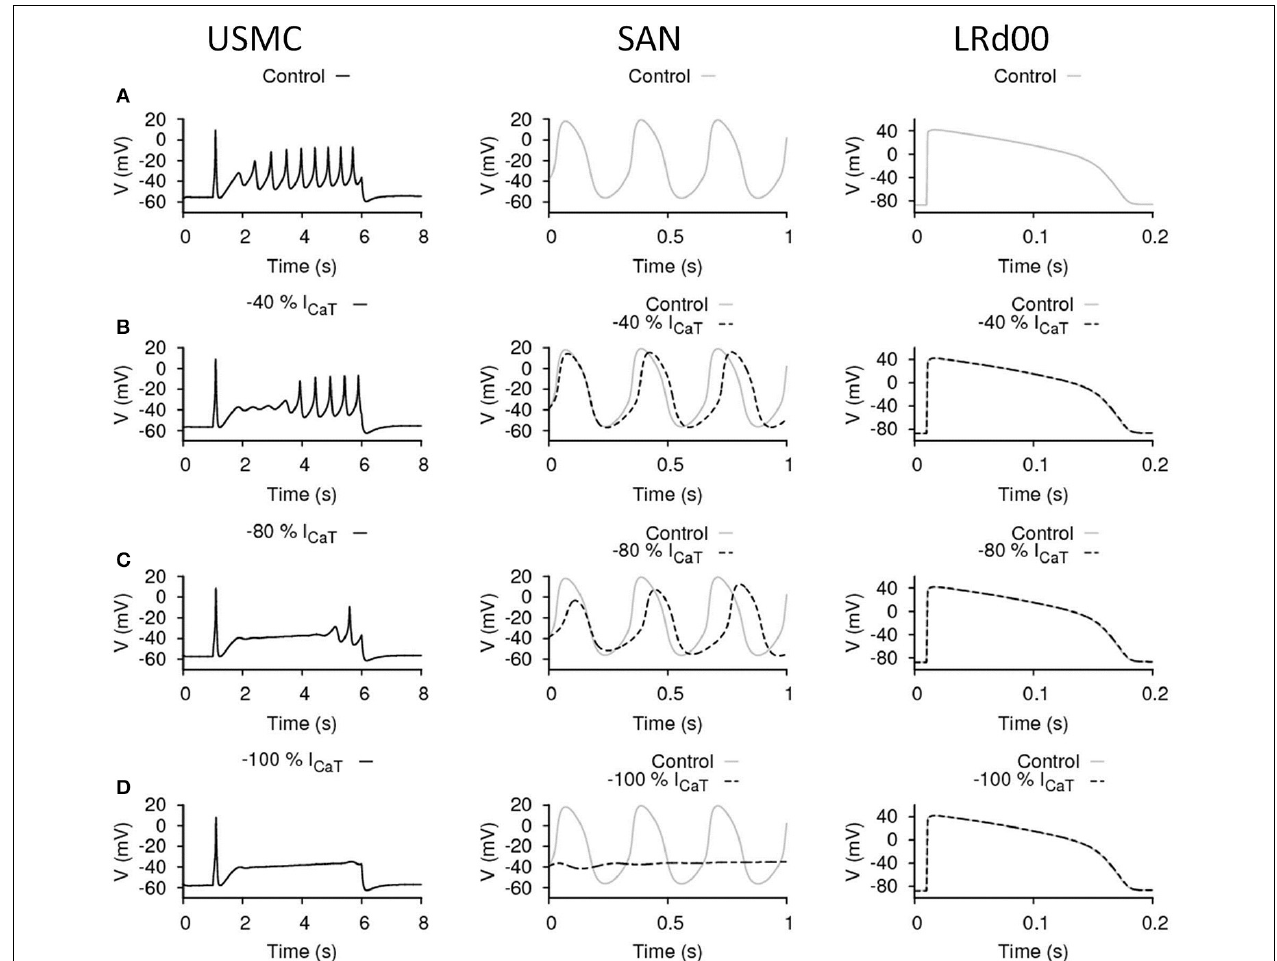
LRd00 ventricular cell model (right). (A) Control configuration at full I CaT and the effects of reducing I CaT by: (B) 40%, (C) 80%, and (D) 100%. The negative sign indicated